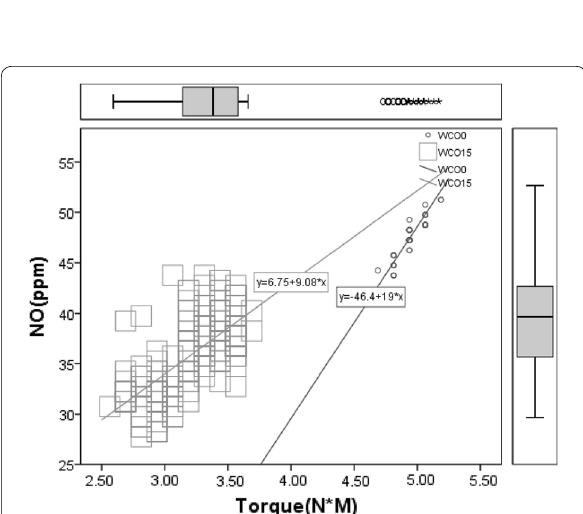
Fig. 13 Scatter plot diagrams for the exhaust characteristics versus torque output [NO emission (Unit: